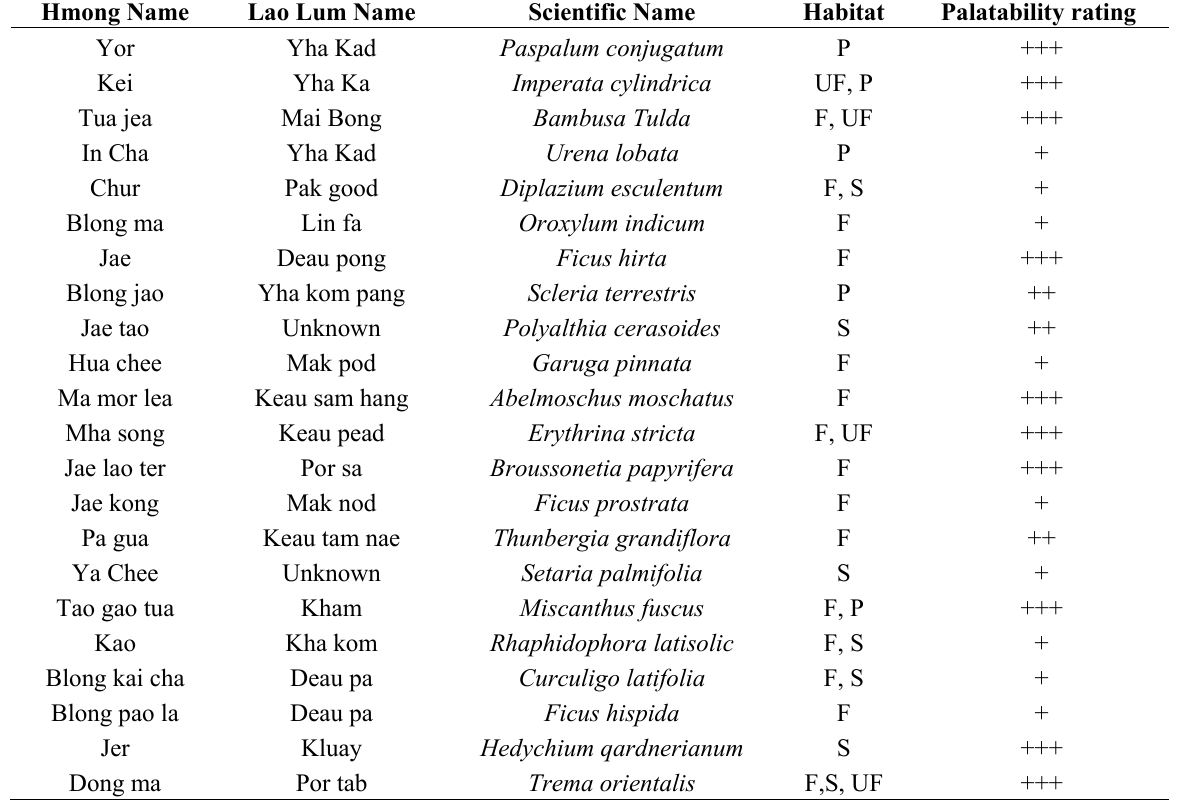
Table 3. List of the main forage species in upland areas of northern Laos with habitat types and palatability rating by Hmong ethnic group. Source: Authors’ survey in Viengphathana and